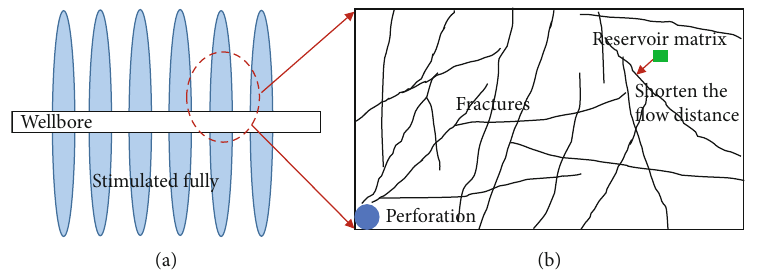
Figure 1: Mechanism schematic diagram of multistage hydraulic fracturing in